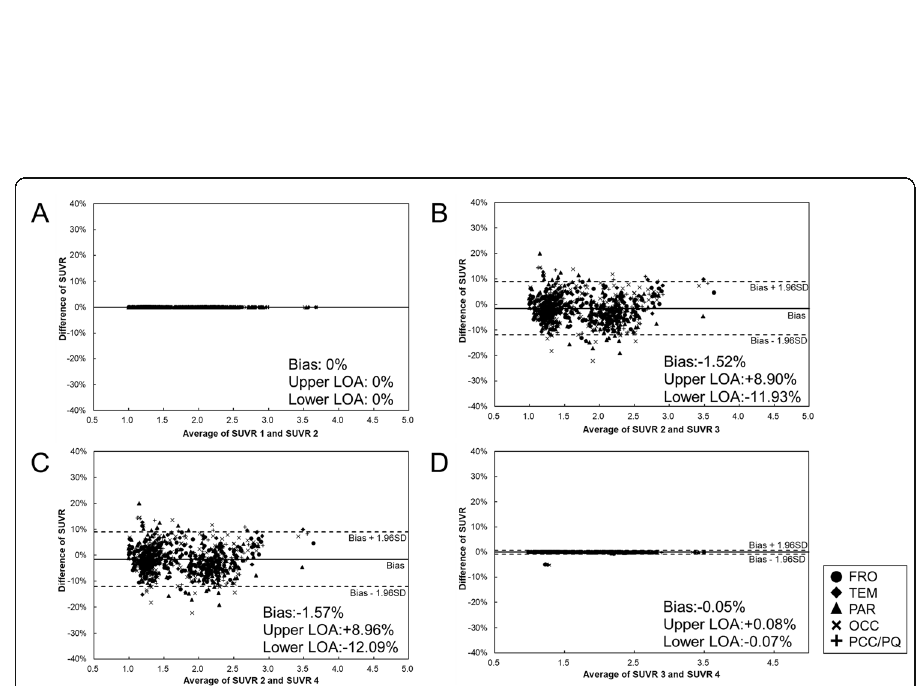
Fig. 6 Bland-Altman analysis for comparing SUVRs. Comparison between SUVR 1 and SUVR 2 ( a ), SUVR 2 and SUVR 3 ( b ), SUVR 2 and SUVR 4 ( c ), and SUVR 3 and SUVR 4 ( d ). The figure shows bias, upper 95% LOA, and lower 95% LOA. FRO frontal lobe, TEM temporal lobe, PAR parietal lobe, OCC occipital lobe,